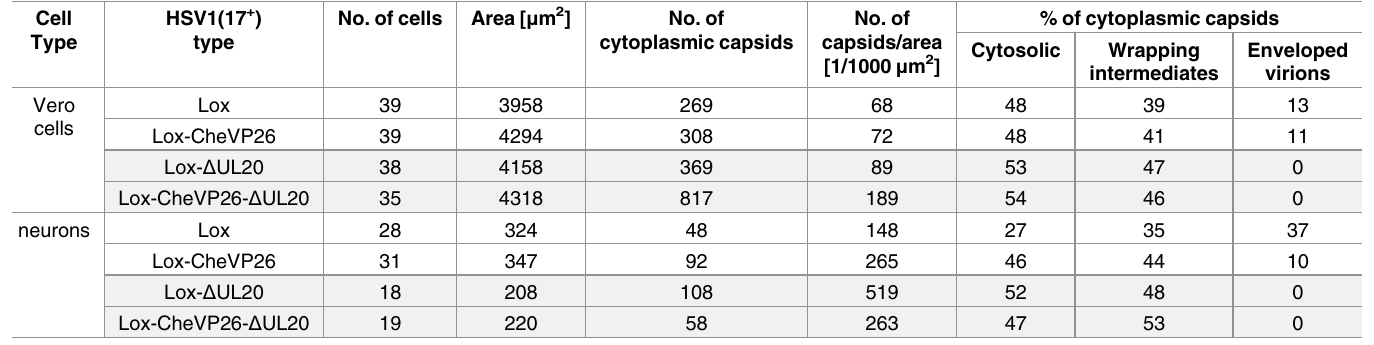
Vero cells or DRG neurons infected with HSV1(17 + )Lox, Lox-mCheVP26, Lox- Δ UL20, or Lox-CheVP26- Δ UL20 were analyzed by electron microscopy, and the number of cytosolic capsids, wrapping intermediates and enveloped virions were